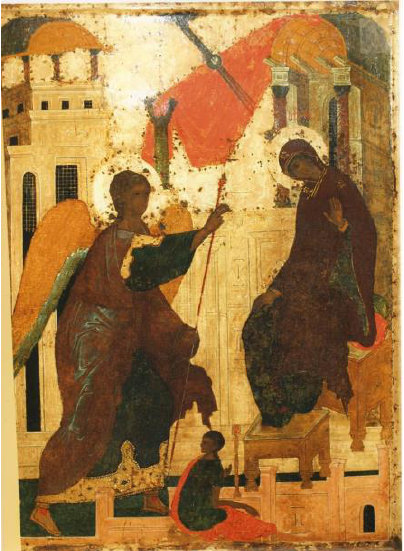
Fig. 8 Annunciation (Andrej Rublev,